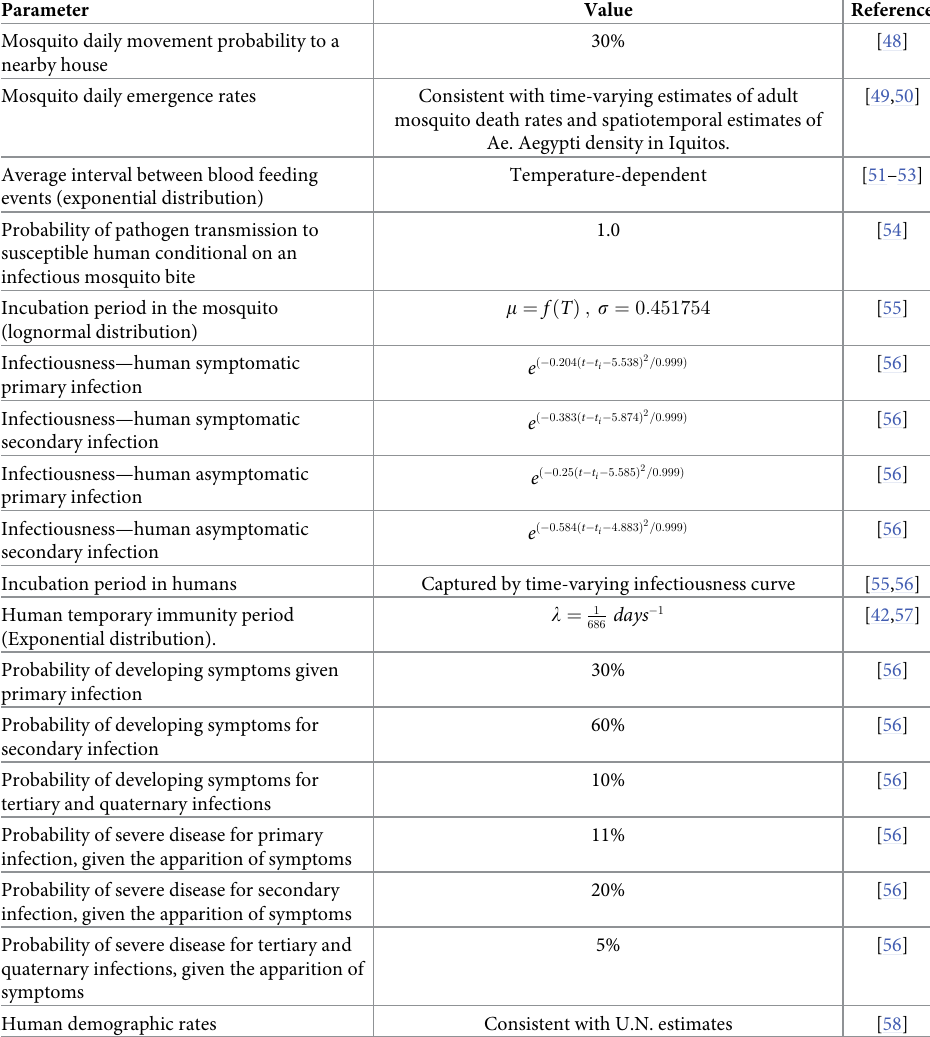
Table 2. Fixed parameters of the